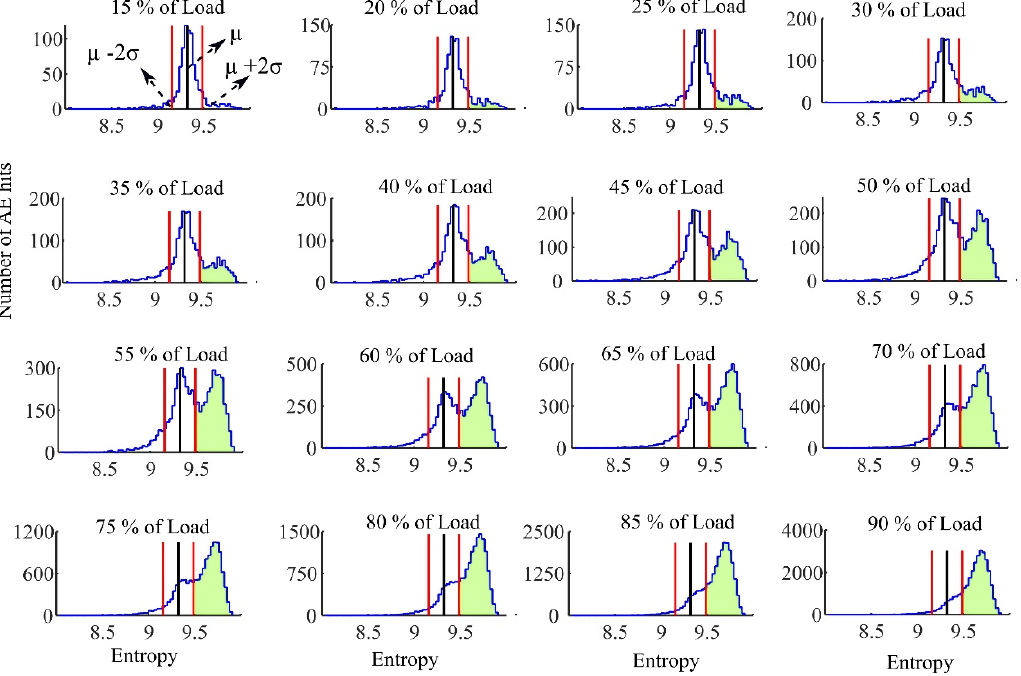
Figure 6. Histogram of the entropy using Fourier transform in different percent of ultimate load. The middle vertical line in each histogram is the mean µ of the histogram for AE hits up to 10–15 percent of the ultimate load. The region between the left- and right-hand vertical lines is that which is within two standard deviations from this mean. These figures show that during the early stages of loading the histogram of the entropy has a shape similar to a normal distribution. Applying increasing load to the FRP rods results in a left tail of distribution longer that is related to smaller entropy events. These small entropies mean the frequency spectrum of detected AE hit has a reduced frequency range and can be due to a specific type of damage being dominant at lower loads of the test. When other types of damage increase substantially, the frequency spectrum of AE hits contains a broader frequency content, due to the diverse damage types [26]. The broader frequency content increases the AE entropy for each event. This leads to the appearance of AE hits with high entropy (shaded regions). The right tail of AE entropy histogram is longer and a new distribution of high AE entropy events formed in the right tail. It can be seen that since both left and right tails of the entropy distribution are increased, the average entropy would not change significantly. However, the right tail that is due to the more damaging events of FRP rods can be used to determine the load. The one-sided Chebyshev’s ine- quality is applied to detect this new distribution in the right tail.